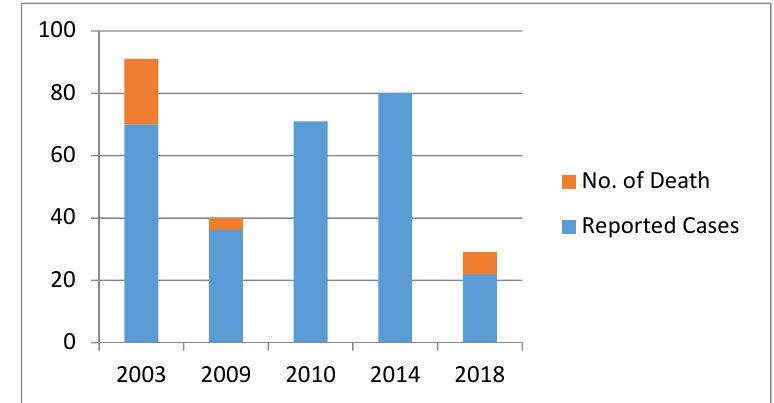
Figure 2. Outbreak of Listeriosis in Australia in 2003, 2009, 2010, 2014 and 2018.